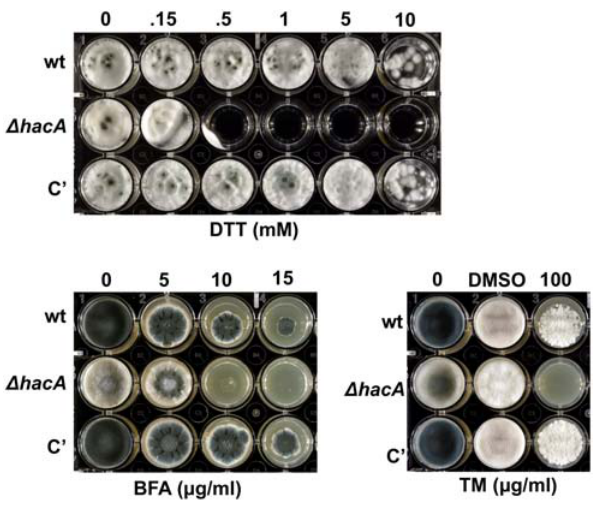
Figure 4. The D hacA mutant is hypersensitive to ER-stress. ER stress was induced by incubating in the presence of DTT, BFA, or TM. For analysis of DTT sensitivity, conidia from the indicated strains were inoculated into liquid AMM–glucose in a multi-well plate containing the indicated concentrations of DTT and incubated at 37 u C for 4 days. For analysis of BFA or TM sensitivity, conidia were inoculated onto solid medium (IMA) in a multi-well plate containing the indicated concen- trations of BFA or TM and incubated at 37 u C for 2–3 days. DMSO was used as the vehicle control for TM. The experiments were performed three times with similar